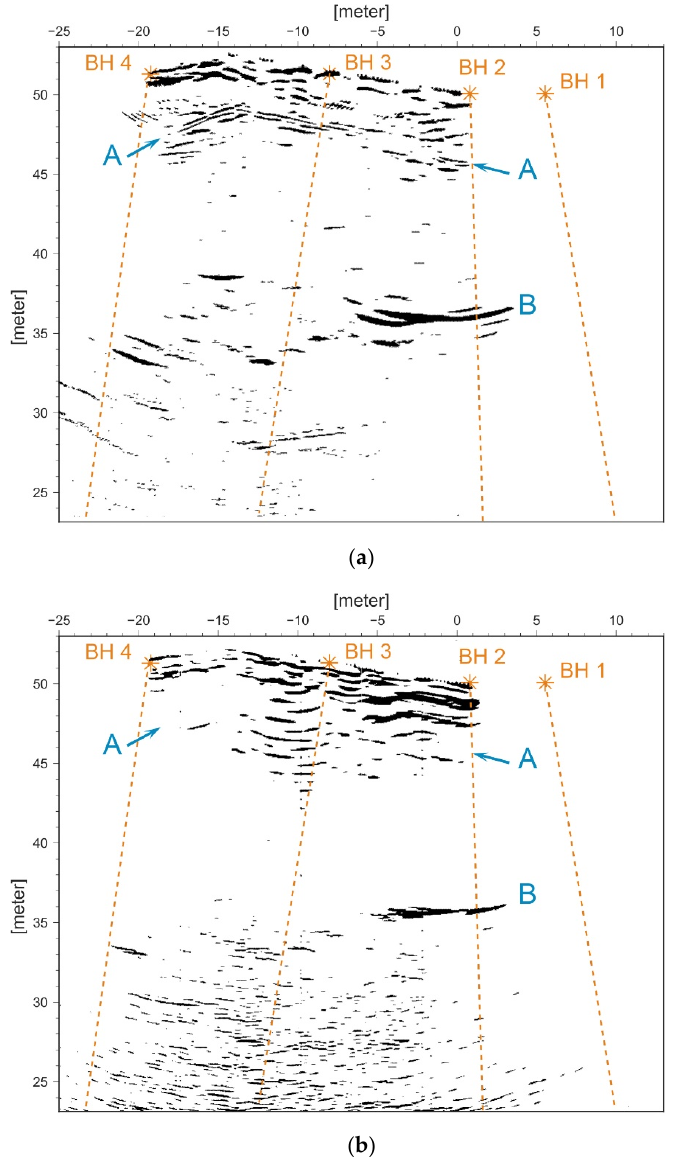
Figure 4. Comparison of the unshielded ( a ) and shielded ( b ) 100 MHz antenna. A marks the reflection traveling back from the gallery from above the antenna. B marks a strong reflection present in both the shielded and unshielded case.